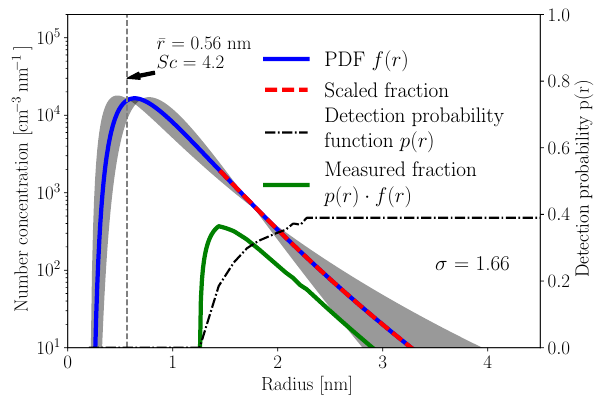
Figure 15. Particle size density as a function of radius (solid lines, left-hand y axis). The blue line shows the estimated lognormal size distribution and the green line the size distribution most likely seen as integral by the PD at 82km. The red dashed line indicates the fraction of the distribution contributing to the PD current. The dashed dotted line shows the detection probability of the PD as ob- tained from aerodynamic simulations (right-hand y axis). The grey shaded areas indicate the error of the distribution due to the uncer- tainty of Sc